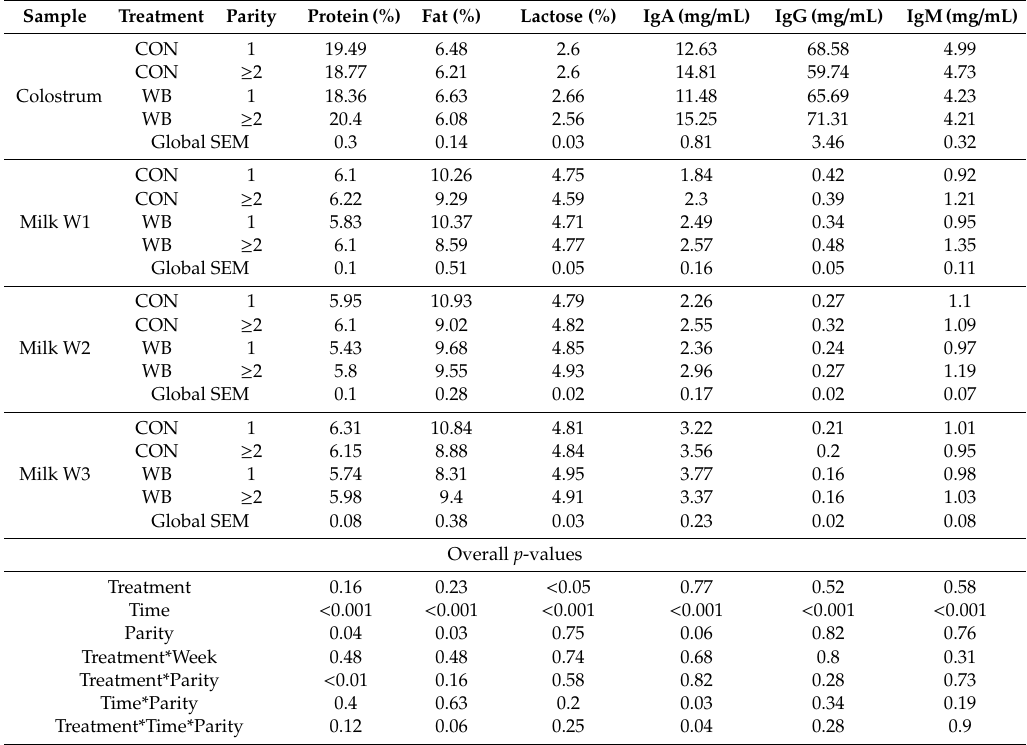
Table 1. Fat, protein, lactose percentage and IgA, IgG and IgM concentrations in colostrum and milk samples collected on a weekly basis after farrowing from control (CON) or wheat bran (WB) sows. Values are presented as mean and SEM given for each period, n = 3 or 4 for each parity within a treatment; W1, W2 and W3 represents week 1, week 2, and week 3; P1 means the first parity of sows, and similarly the p ≥ 2 means the parity of sows are more than 2, which are multiparous sows. * points to interaction e ff ects between the respective